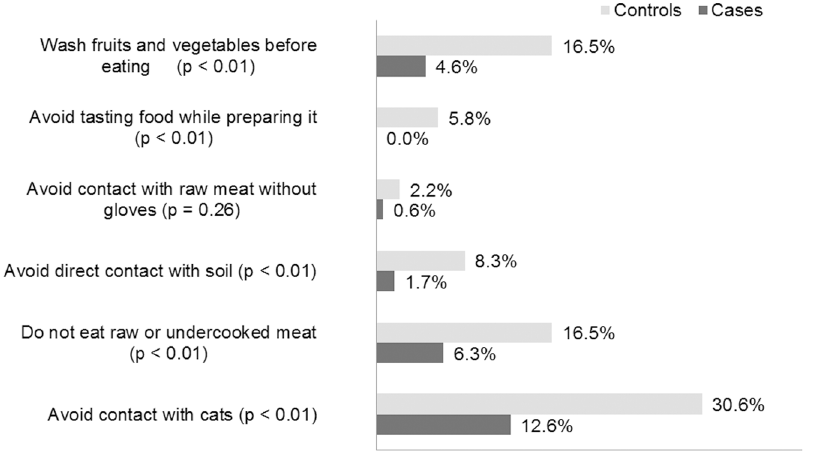
Figure 2. Bar diagram based on the proportion of mothers in both case (175) and control (278) groups who claimed to have knowledge of how to prevent toxoplasmosis.